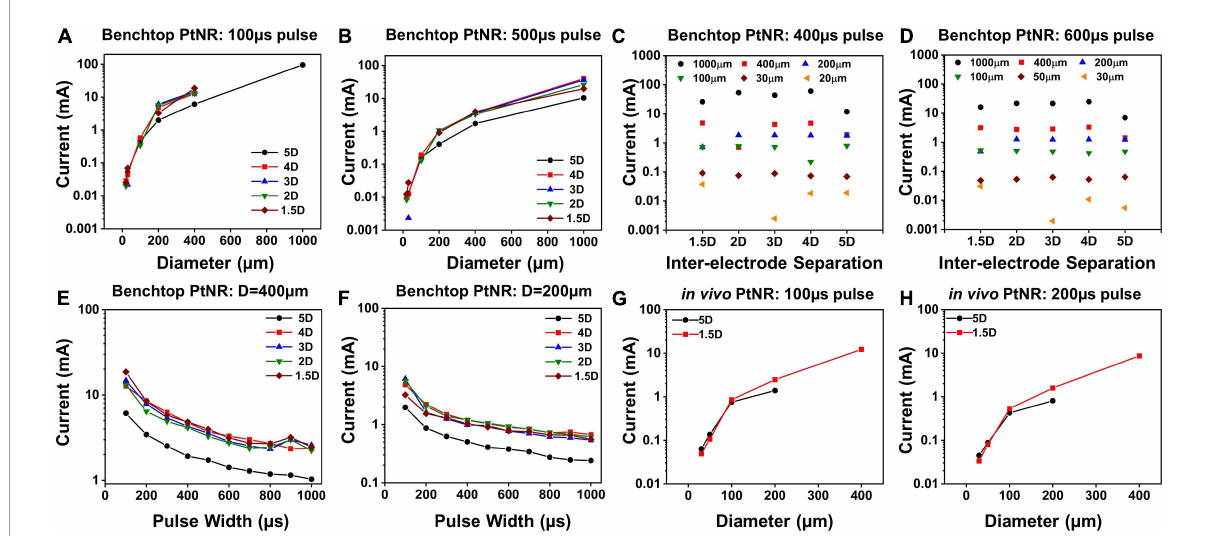
FIGURE6 Maximum injectable current for PtNR contacts as a function of (A) diameter for a 100 µ s pulse and for different inter-contact separation in benchtop setting, (B) diameter for a 500 µ s pulse and for different inter-contact separation in benchtop setting, (C) inter-contact separation for a 400 µ s pulse and for different diameters in benchtop setting, (D) inter-contact separation for a 600 µ s pulse and for different diameters in benchtop setting, (E) injected pulse width for a 400 µ m contact diameter and for different inter-contact separation in benchtop setting, (F) injected pulse width for a 200 µ m contact diameter contact in benchtop setting, (G) diameter for a 100 µ s pulse for two different inter-contact separations in vivo , (H) diameter for a 200 µ s pulse for two different inter-contact separations in vivo